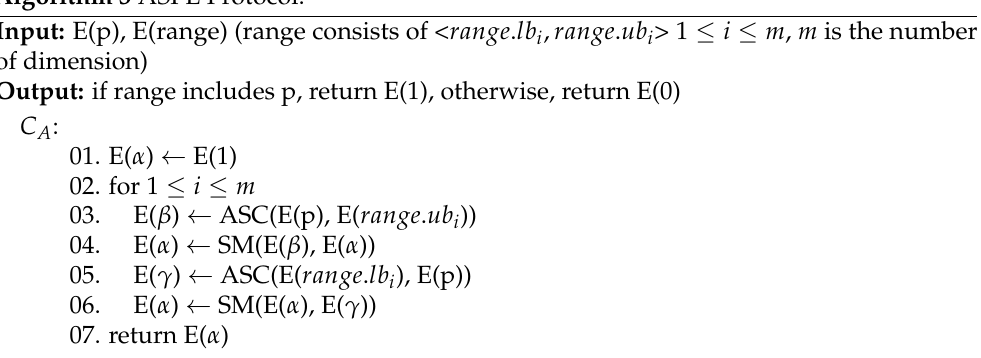
Algorithm 3 ASPE